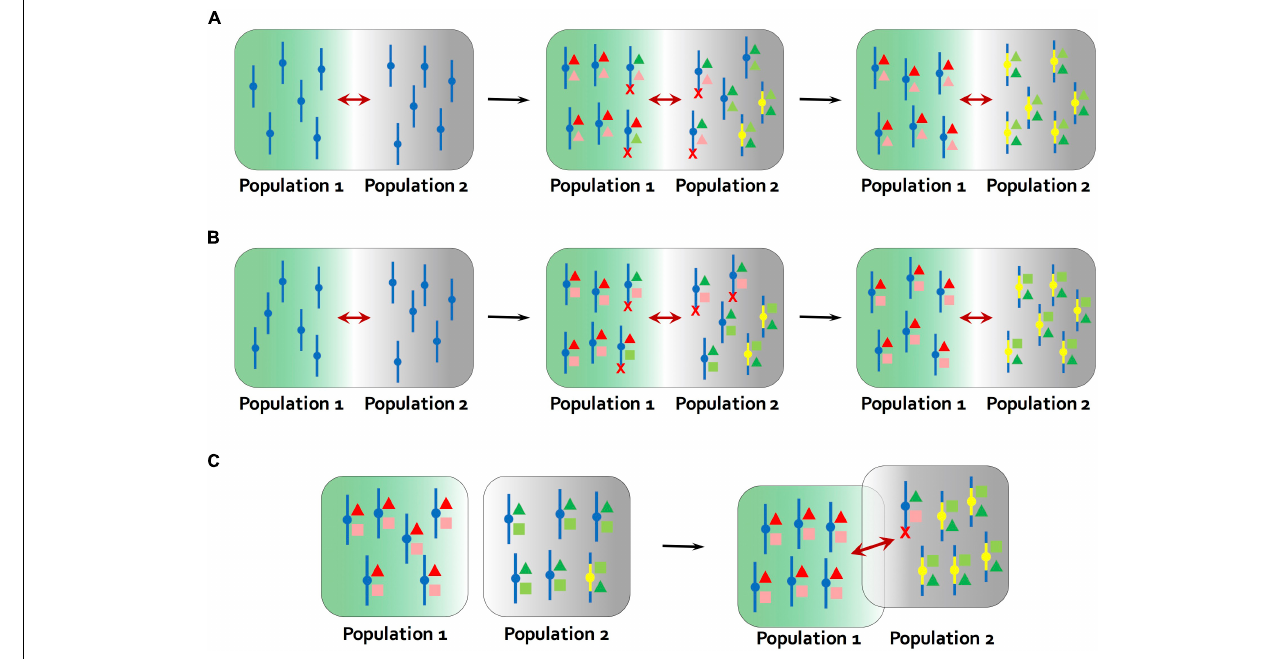
FIGURE 2 | Models for the establishment of inversions. (A) Kirkpatrick and Barton (2006) model. At the starting point, population 1 and 2 occur in different environments, but are connected by gene flow (maroon arrows). Different alleles (red and green colors) at multiple genes underlying the same locally adapted trait (deep color and light color triangles) are favored in local environments (green and gray backgrounds). The ancestral chromosome carries mixtures of adapted and maladapted alleles in the face of gene flow, while a new inversion carries only the locally adapted alleles (yellow bars). The inversion is therefore favored and rises to high frequency in population 2. (B) Inversions become established through a process similar to (A) but by carrying a combination of alleles at two loci that are adapted to different aspects of the local environment (triangles and squares in different colors). For example, in a dune ecotype of the prairie sunflower ( Helianthus petiolaris ), larger seed size and tolerance to low nutrient soils were found to map to the same inversions (Huang et al., 2019; Todesco et al., 2019). (C) Mixed geographic model proposed by Feder et al. (2011). At the starting point, population 1 and 2 are allopatric. Multiple locally adapted alleles (triangles and squares in different colors) are fixed due to lack of gene flow, and an inversion carrying a full complement of these alleles is present at low frequency in population 2 through mutation-purifying selection balance or genetic drift. At secondary contact, the reduction in recombination caused by the inversion results in a selective advantage over collinear regions, leading to rise of inversion frequency. Red crosses indicate that chromosomes carrying maladaptive combinations of alleles are eliminated in each